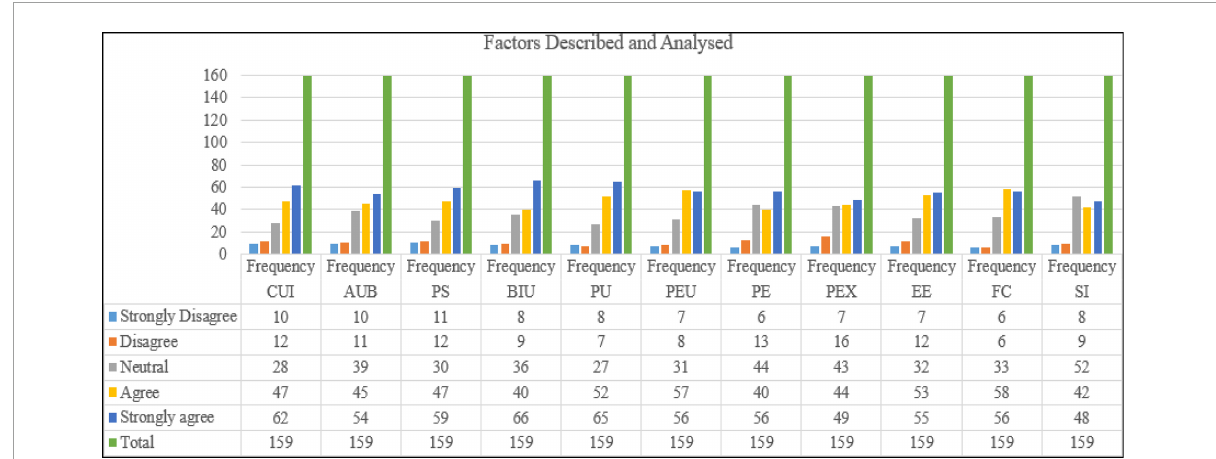
FIGURE4 Factors described and